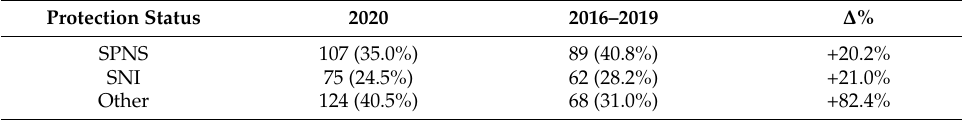
Table 6. Frequency of rescues and the protection status of natural